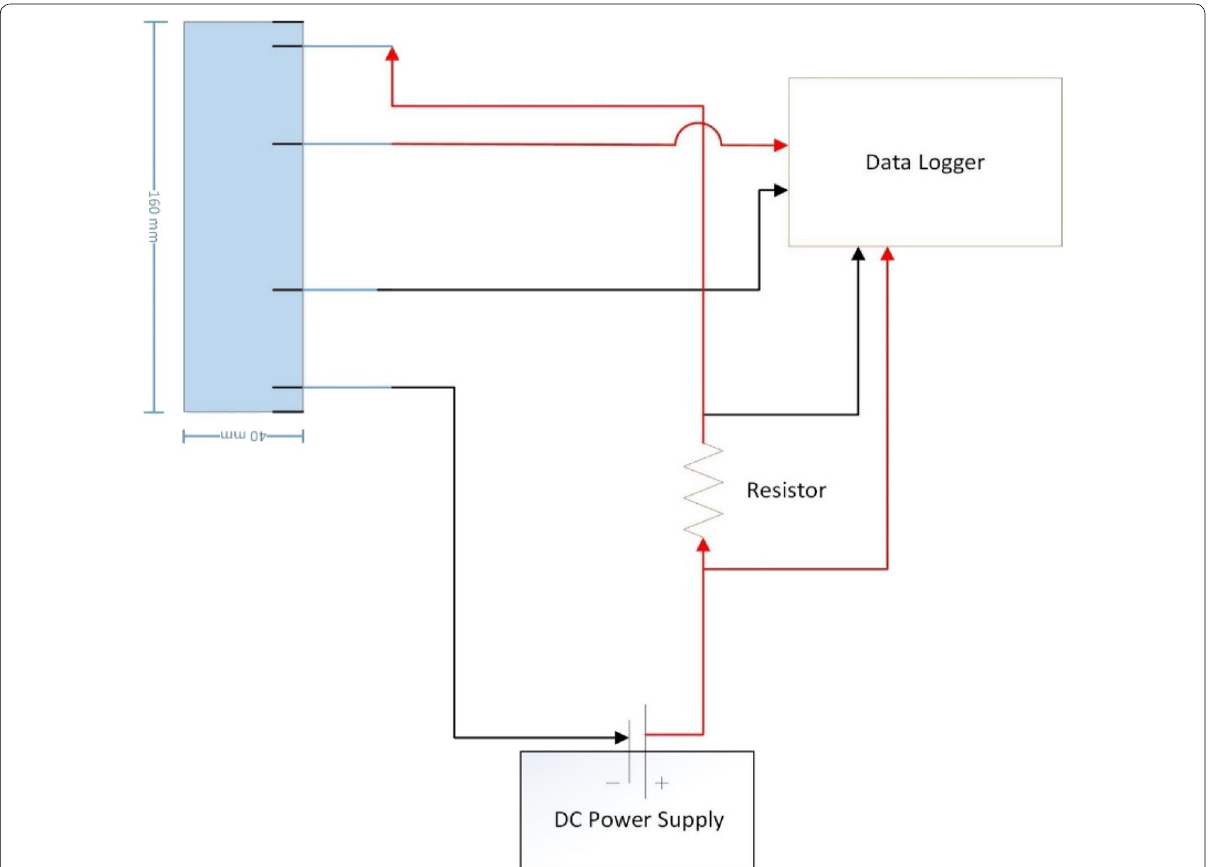
Fig. 4 Schematic illustration of the electrical connections in four-probe resistivity method (Rehman et al. 2018).